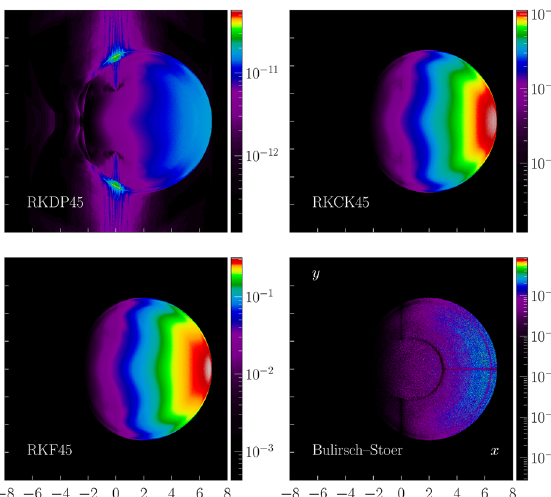
Fig. 7 Averageofthehamiltonianconstraintwith r 0 = 100.Upperleft panel: RK Dormand-Prince; upper right panel: RK Cash-Karp; lower left panel: RK Fehlberg; lower right panel: BS algorithm